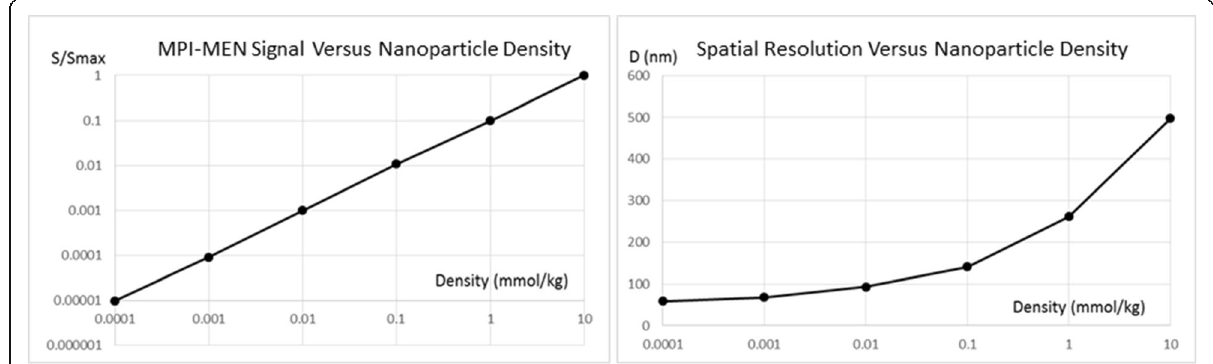
Fig. 5 Nanoparticle density dependence of the signal and spatial resolution of MPI with 50-nm